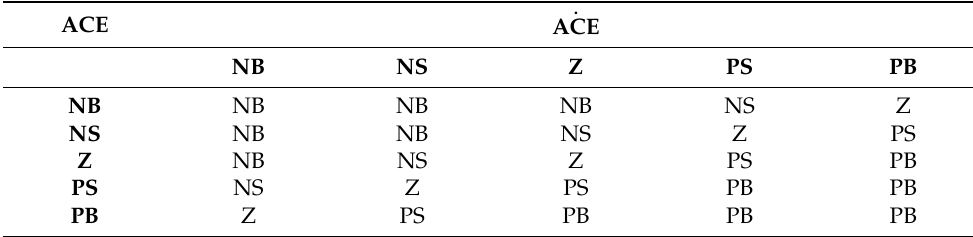
Table 1. Fuzzy role